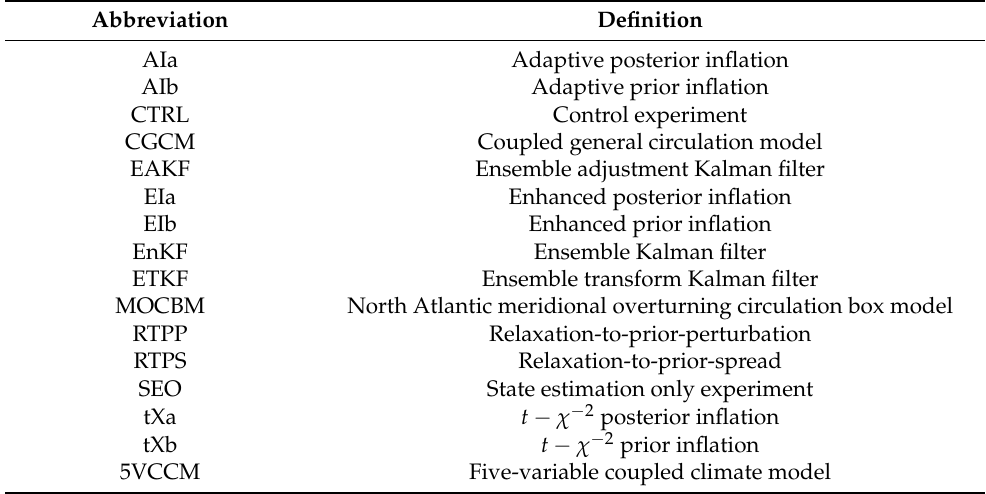
Table A1. Abbreviations and definitions used in this